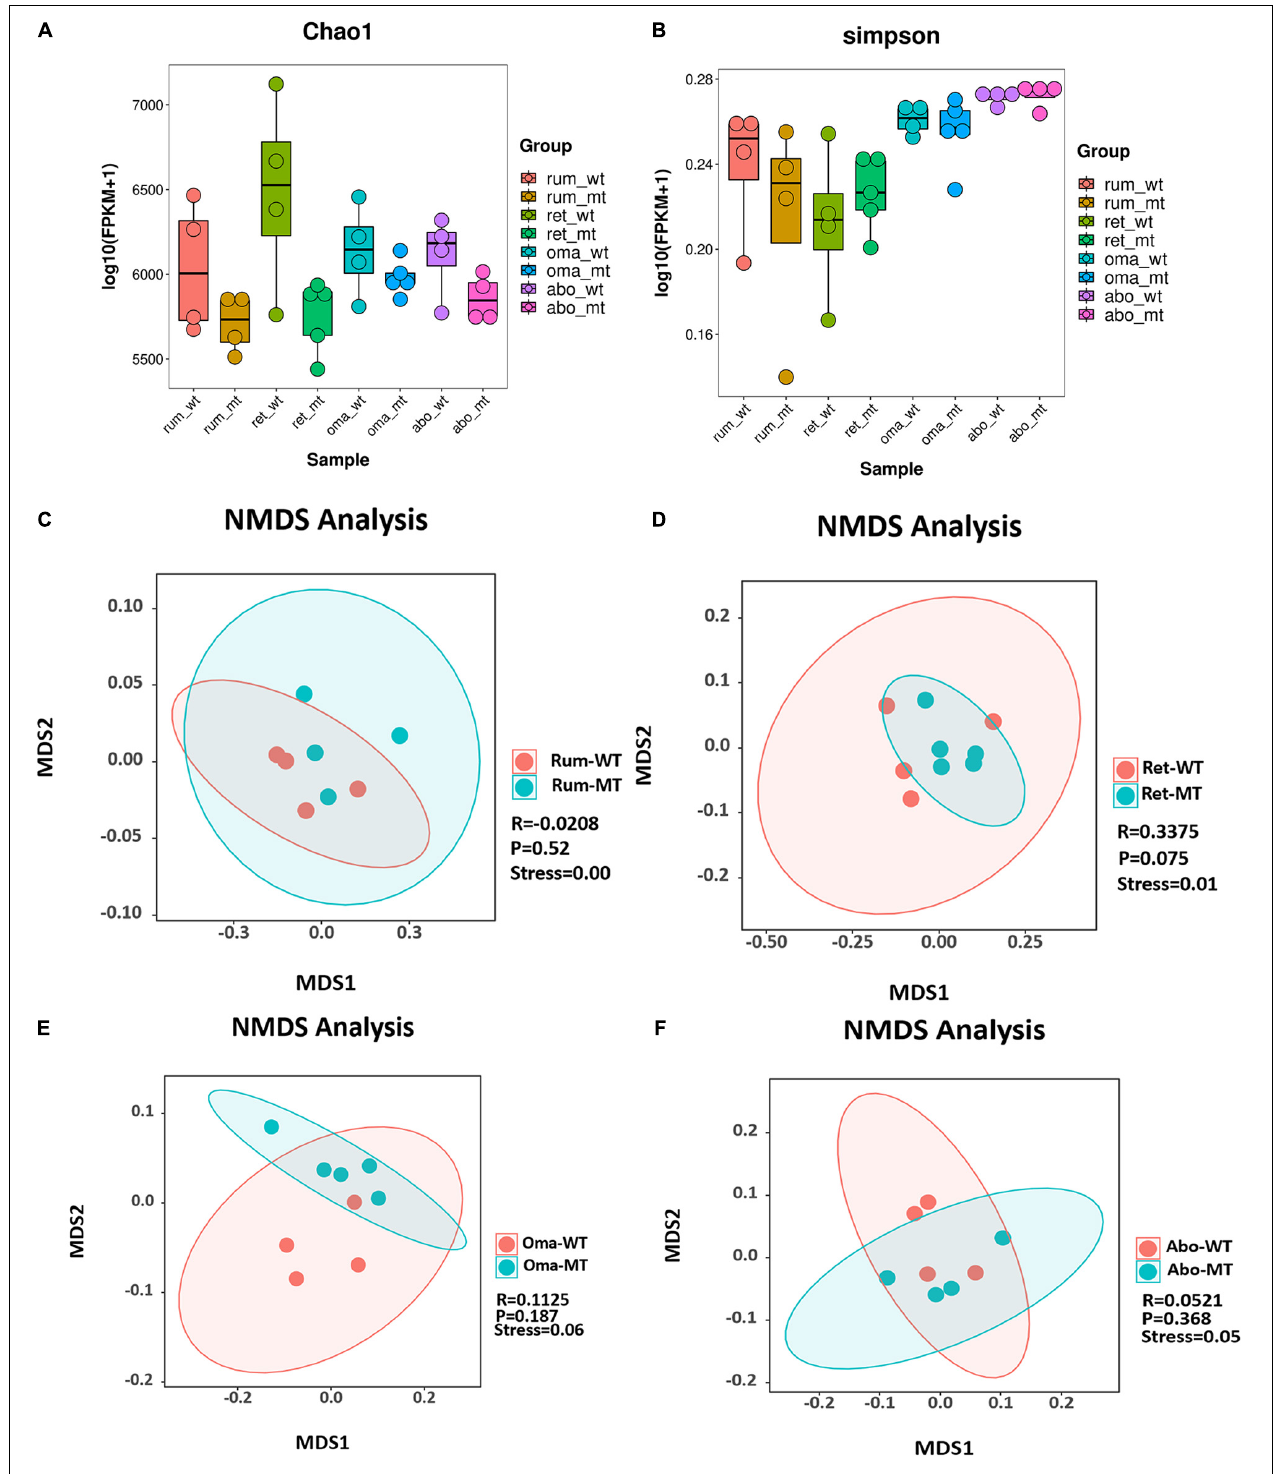
FIGURE 1 | Diversity and structural analysis of MSTN + / − and WT cattle. Box plots showing chao1 (A) and Simpson (B) of indices in both MSTN + / − and WT four stomach samples. Non-metric multidimensional scaling (NMDS) ordination plot assessed by Bray–Curtis in both MSTN + / − and WT rumen (C) , reticulum (D) , omasum (E) , and abomasum samples (F) . Stress values for ordination plot were < 0.1, which indicated the accuracy of data representation in a two-dimensional space. When stress values < 0.05, it has a good representative. rum, rumen; ret, reticulum; oma, omasum; abo, abomasum; WT, wild-type cattle; MT, MSTN + / −